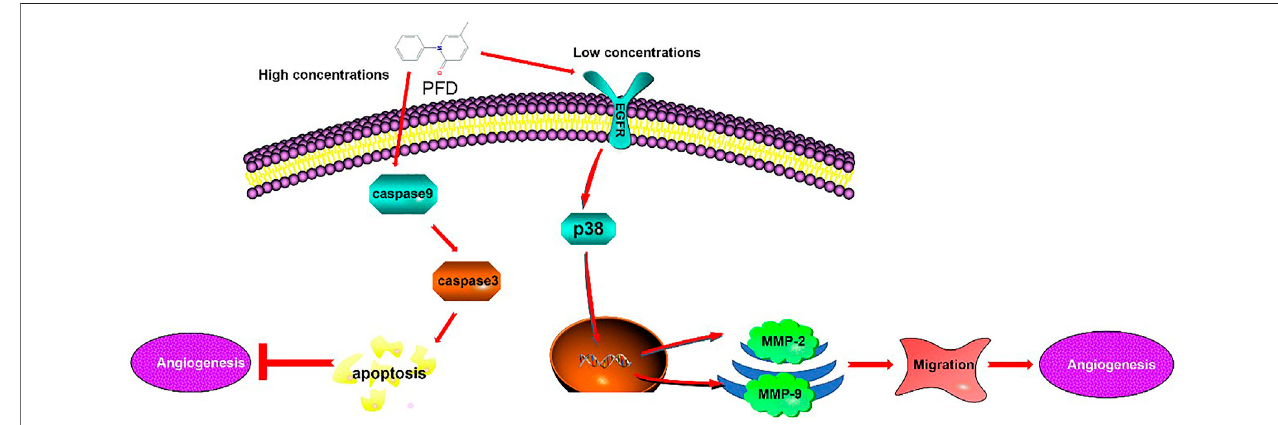
FIGURE7| Mechanism underlying theBiphasic effect ofpirfenidone onangiogenesis: PFDelicitsabiphasiceffecton angiogenesis through differentmechanisms, whereby high concentrations inhibit angiogenesis in EA.hy926 cells by increasing apoptosis, and low concentrations promote angiogenesis through the activation of speci fi c signaling